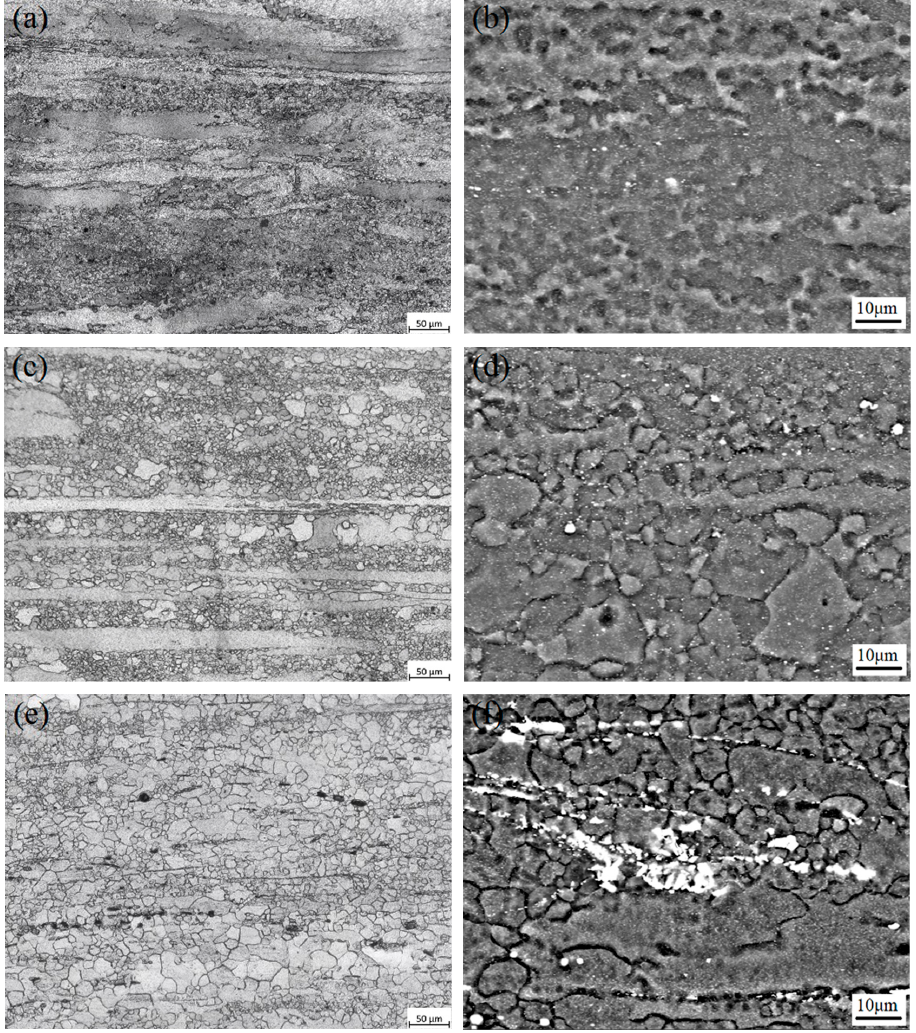
Figure 5. Optical microstructure and SEM images of as-extruded samples: ( a , b ) Mg-6Sn; ( c , d ) Mg-6Sn-2Zn; and ( e , f ) Mg-6Sn-2Zn-1Ca.